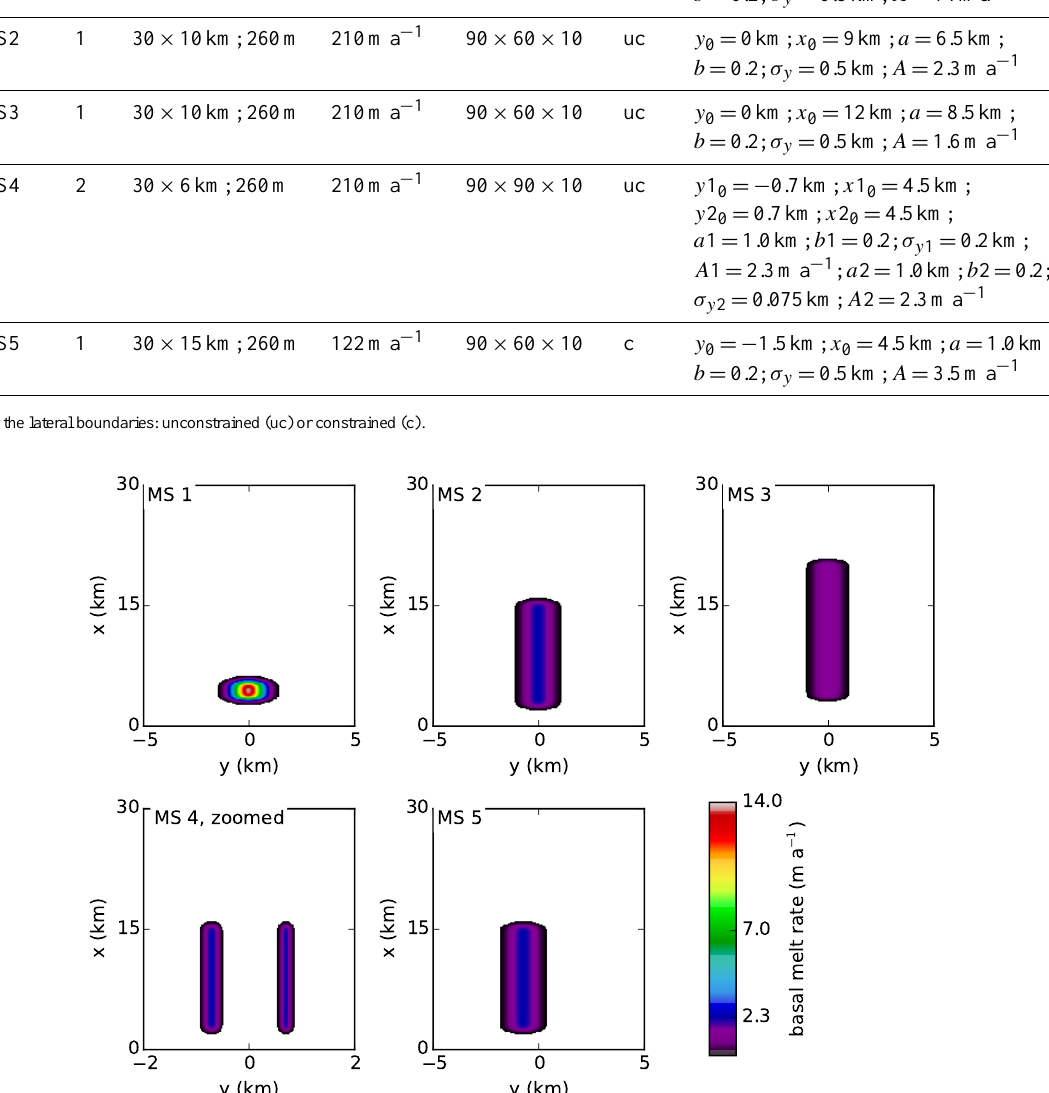
floating, channels are carved into the steady-state ice shelf with an approximately 4 km seaward offset. This hampers the investigation of how channels behave directly at the ground- ing line, but does not impact the channel evolution farther downstream. The latter is the focus of this study, as field data have been collected relatively close to the ice-shelf front (Fig.